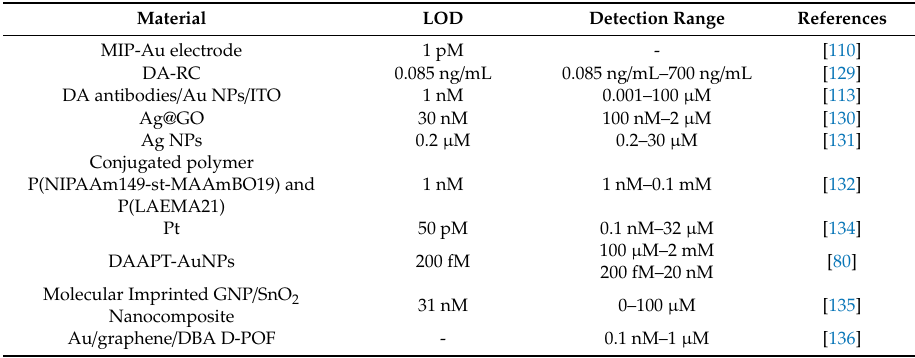
Table 1. SPR sensors for dopamine (DA)